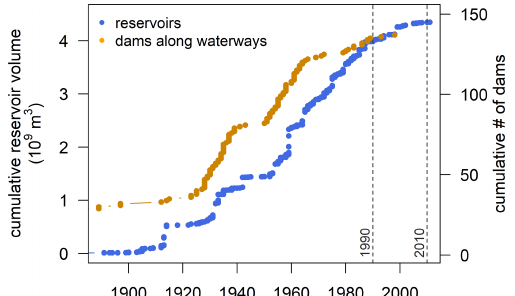
Figure 11. Cumulative volume of reservoirs in Germany and number of dams (barrages) along the German waterways since the start of construction in the 1880s. The cumulative vol- ume of reservoirs includes only large reservoirs with volumes > 0 . 04 × 10 6 m 3 and was taken from Wikipedia (“Liste der Talsperren in Deutschland”, https://de.wikipedia.org/wiki/Liste_ von_Talsperren_in_Deutschland, last access: January